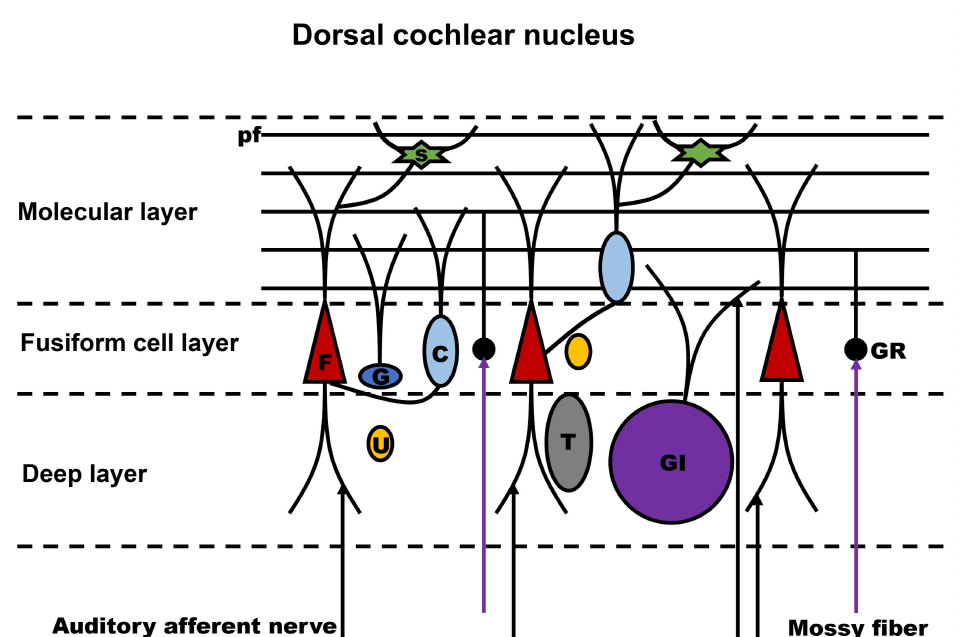
Figure 2. Cerebellum-like laminar structure in the DCN. Similarity of structural feature between the DCN and the cerebellum is a molecular layer that includes parallel fibers derived from granule cells. pf, parallel fibers; F, fusiform cell; G, Golgi cell; U, unipolar brush cell; s, stellate cell; C, cartwheel cell; T, tuberculoventral cell; GI, giant cell; GR, granule